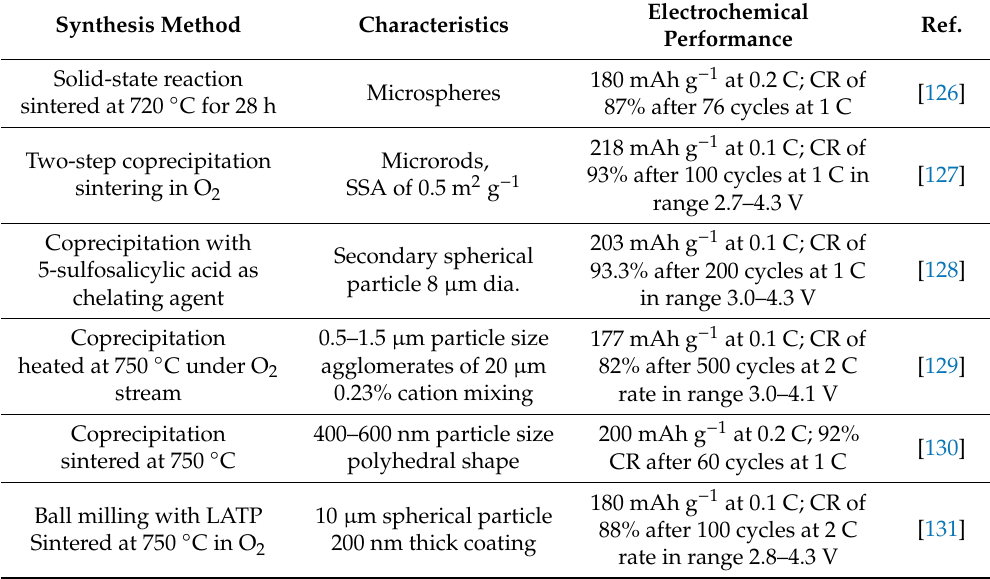
Table 1, illustrating the dependence on the synthesis route, morphology of the particles, and coating, including selected results [126–131]. Table 1. Electrochemical properties of selected uncoated and coated LiNi 0.80 Co 0.15 Al 0.05 O 2 cathode materials (CR = capacity retention; SSA = specific surface area; LATP = Li 1.3 Al 0.3 Ti 1.7 (PO 4 ) 3 fast ion